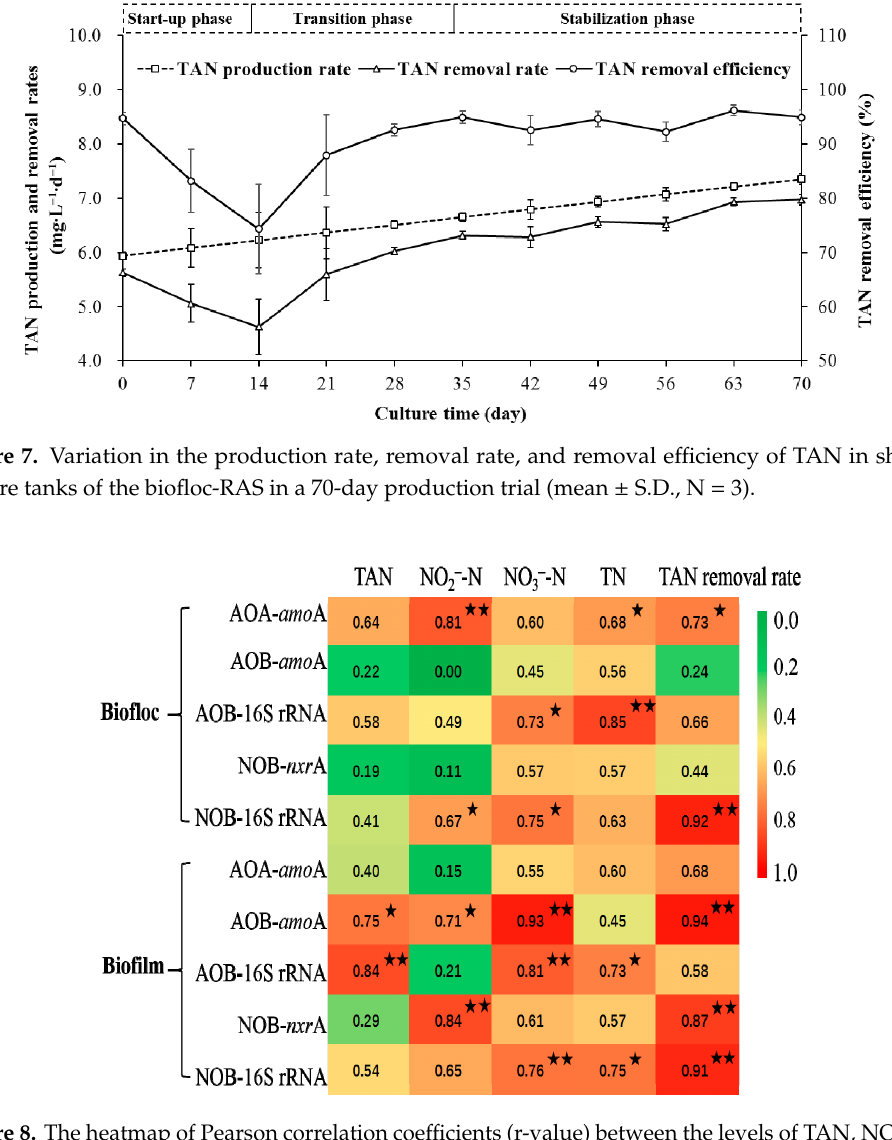
Figure 8. The heatmap of Pearson correlation coefficients (r-value) between the levels of TAN, NO 2 − -N, NO 3 − -N, TN, TAN removal rate and abundances of AOA, AOB, NOB in biofloc and biofilm from the biofloc-RAS for shrimp intensive culture in a 70-day trial. Significance: * p < 0.05; ** p < 0.01.